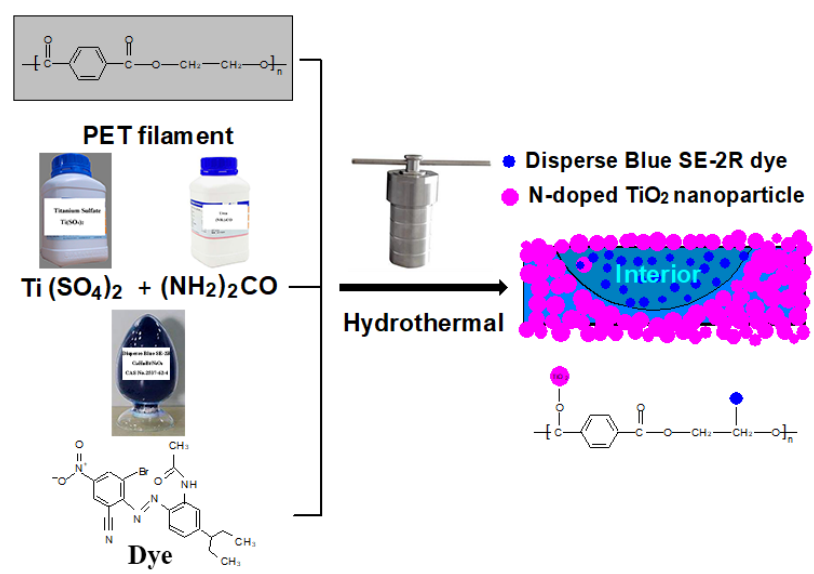
Figure 9. Schematic illustration of the fabrication route of scheme one for the PET filaments deposited with dye-sensitized N-doped TiO 2 nanoparticles.